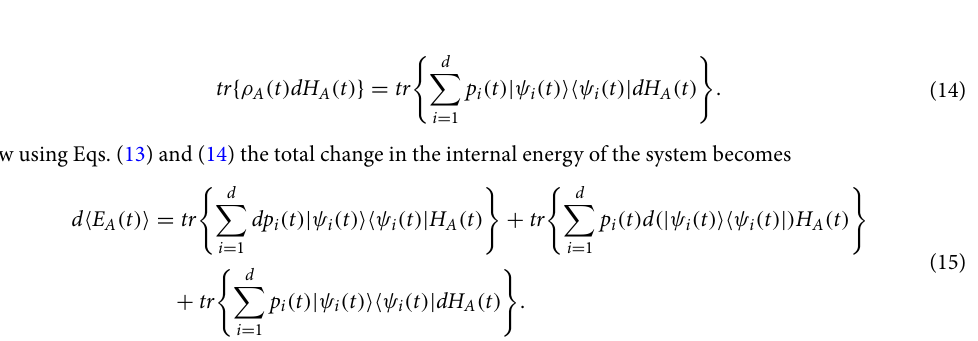
Figure 3. A quantum system A (system of interest) is in contact with another quantum system B (environment). The total system AB is insulated against heat from the surroundings. There is flow of energy between the two systems due to the interaction. External work is also done on system A through an external